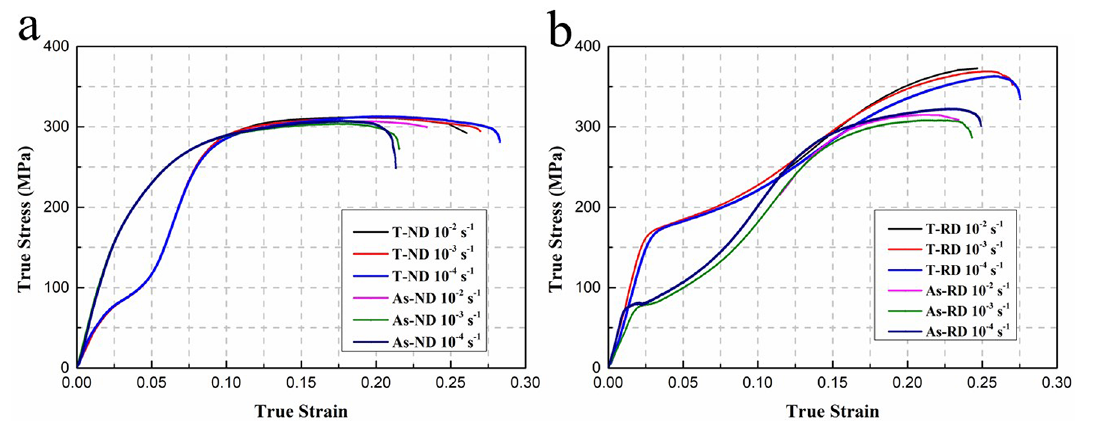
Figure 5. True stress–strain curves of specimens obtained from quasi-static compression tests. (a) axis//ND (b) axis//RD